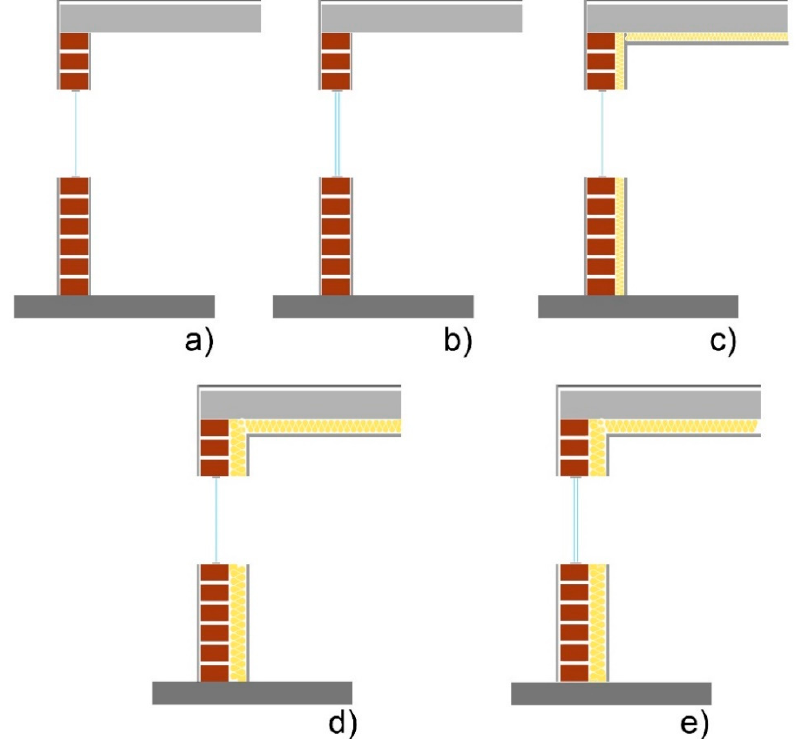
Figure 5. Section drawings of the different building fabric typologies used in the dynamic simulations. Each cross-section is explained below identified by its letter: ( a ) as built; ( b ) double glazing, no insulation; ( c ) single glazing and 3 cm of insulation (as established by the NOM-ENER-020); ( d ) single glazing and 5 cm of insulation (standard practice); ( e ) double glazing and 5 cm of insulation.